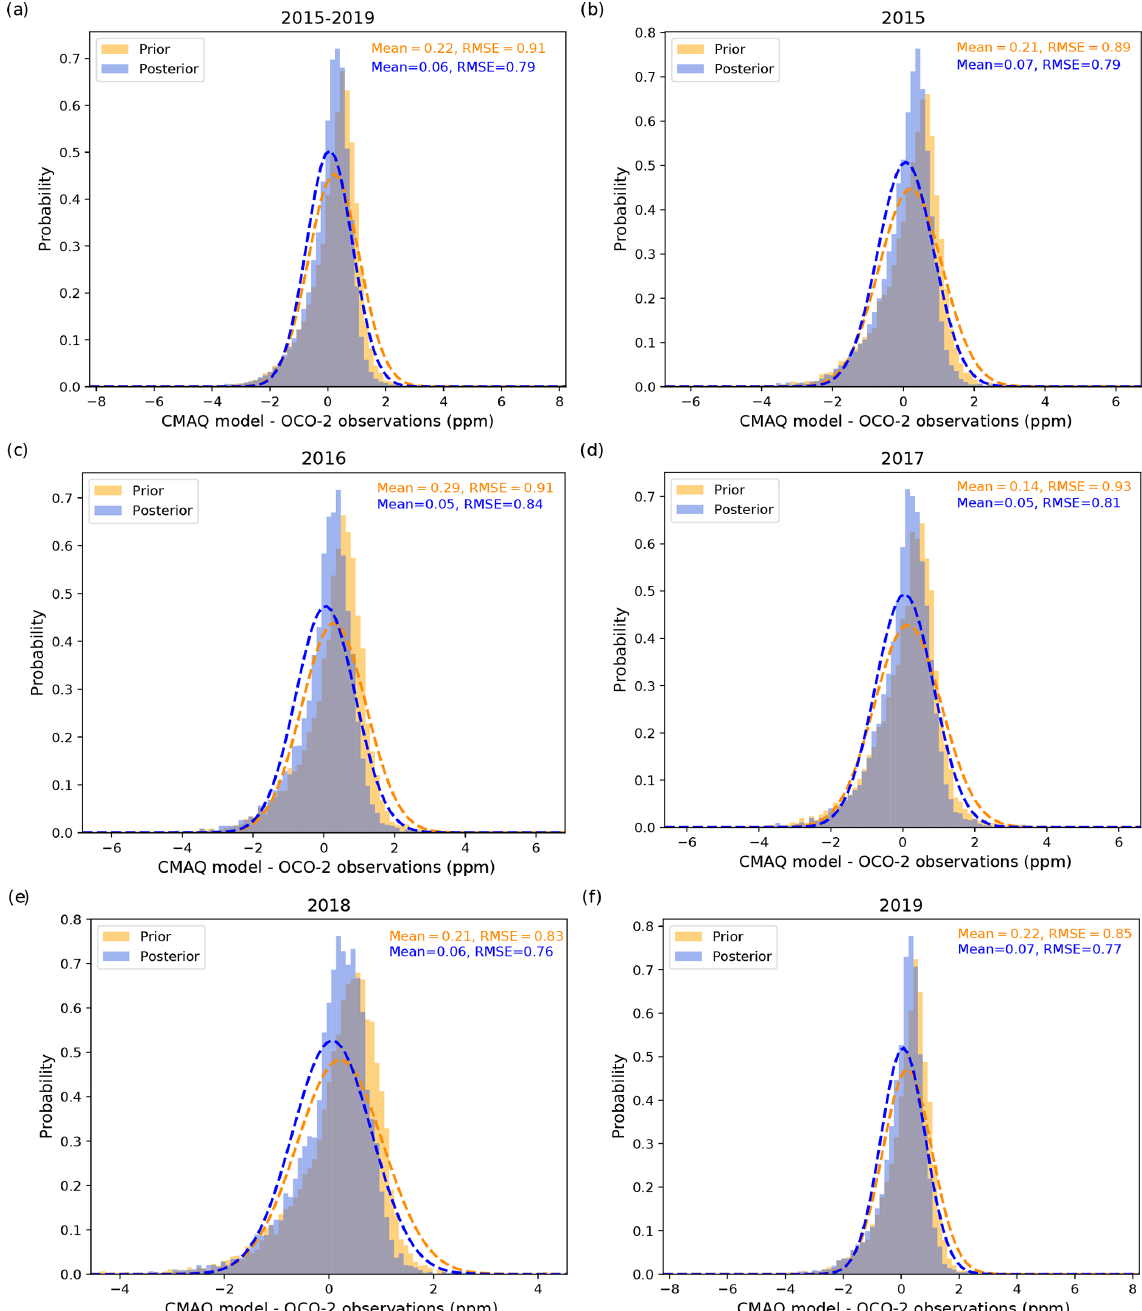
Figure A1. Probability density distribution of the difference between the CMAQ column-averaged CO 2 concentration and OCO-2 obser- vations (in ppm). The orange histogram presents the prior CMAQ column-averaged simulated concentration minus OCO-2, whereas the blue histogram presents the posterior column-averaged simulated concentration minus the OCO-2. The mean differences and the RMSE are indicated in the